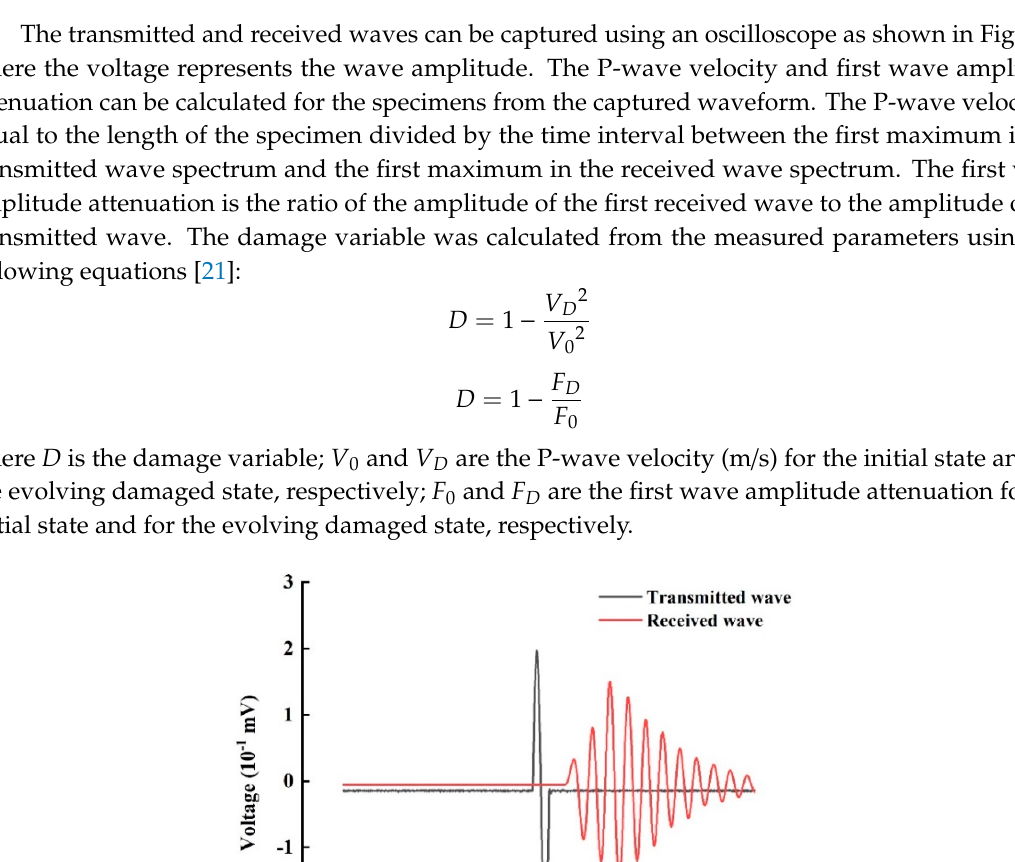
Figure 4. Ultrasonic testing setup.